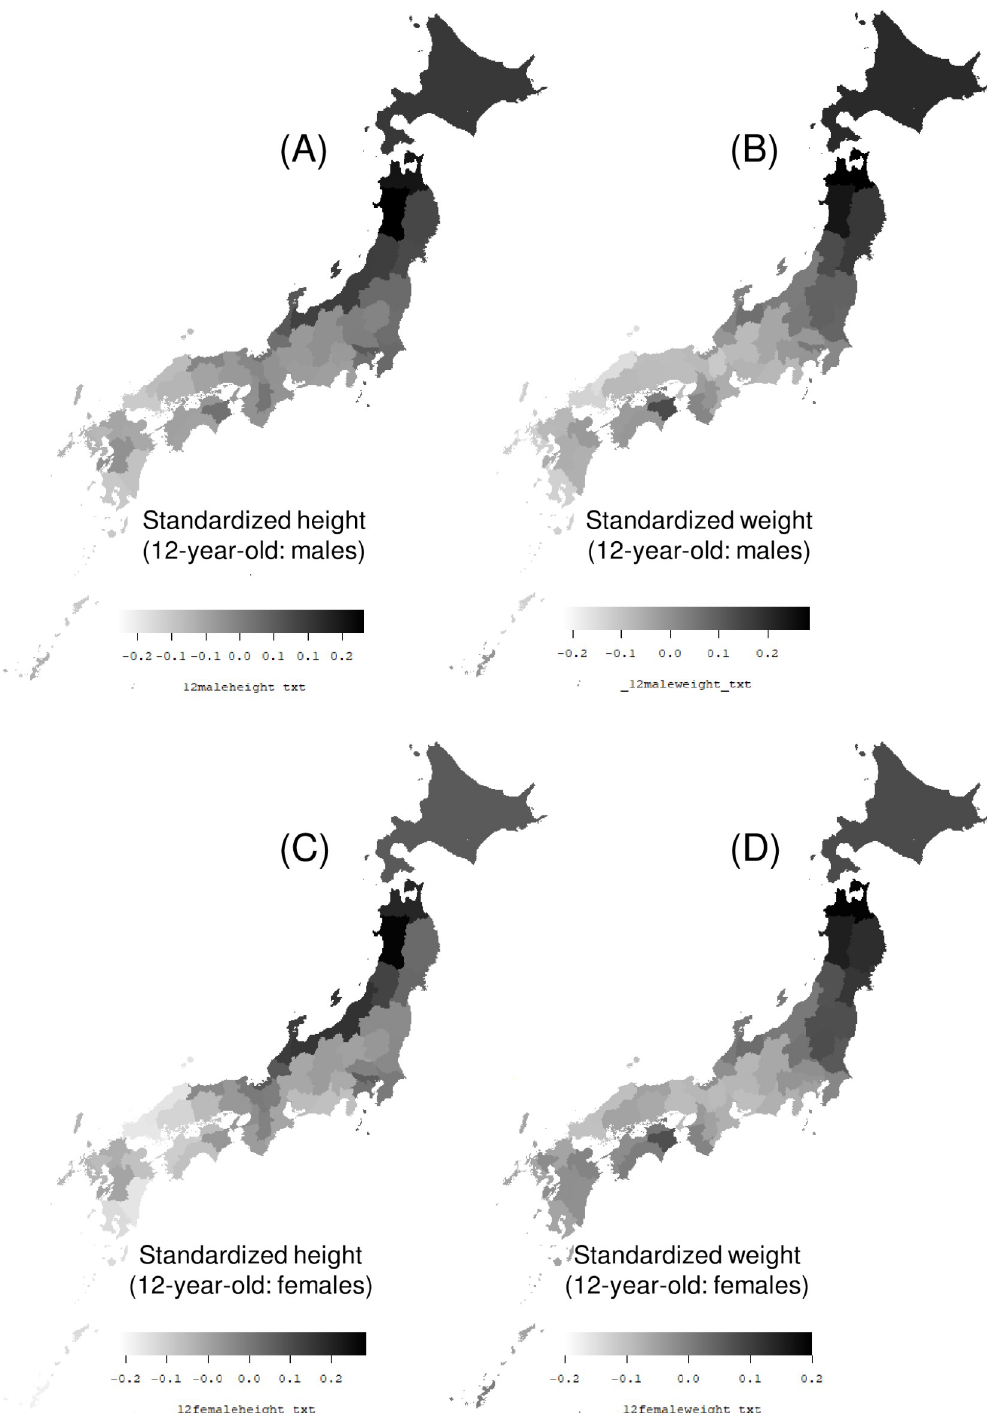
Fig 1. Map of the distribution of standardized heights and weights of Japanese youth. Map of the distribution of the 25-year (1989 to 2013) average of standardized heights and weights of the following subject groups, in each prefecture: (A) Heights of 12-year-old boys, (B) weights of 12-year-old boys, (C) heights of 12-year-old girls, and (D) weights of 12-year-old girls.